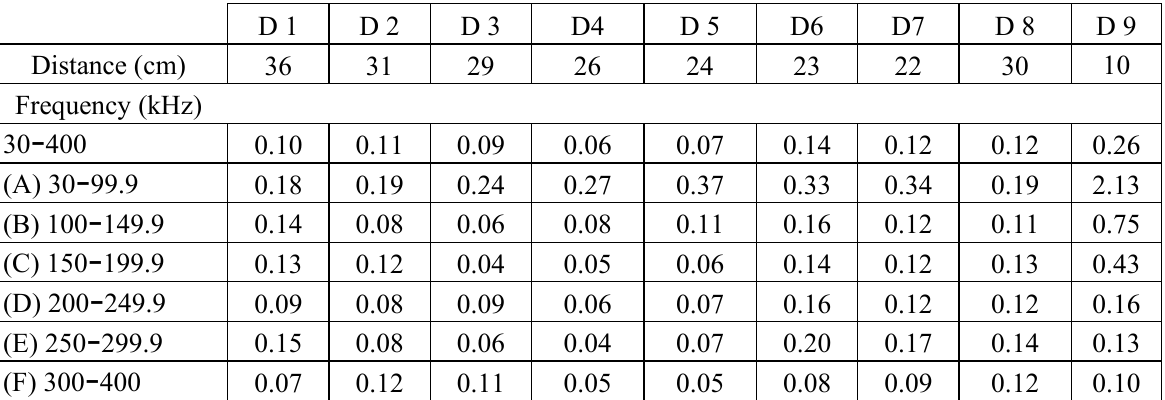
Table 3. RMSD-S for PZT 2.